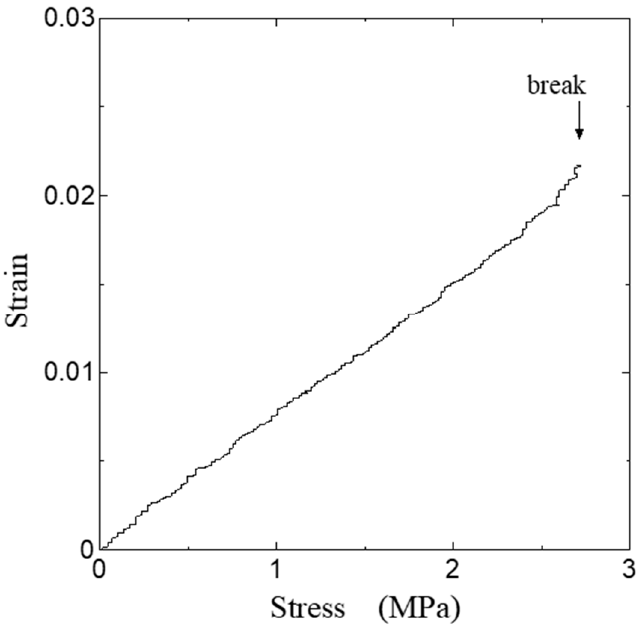
Figure 4. Stress–strain curve of the chitin film.